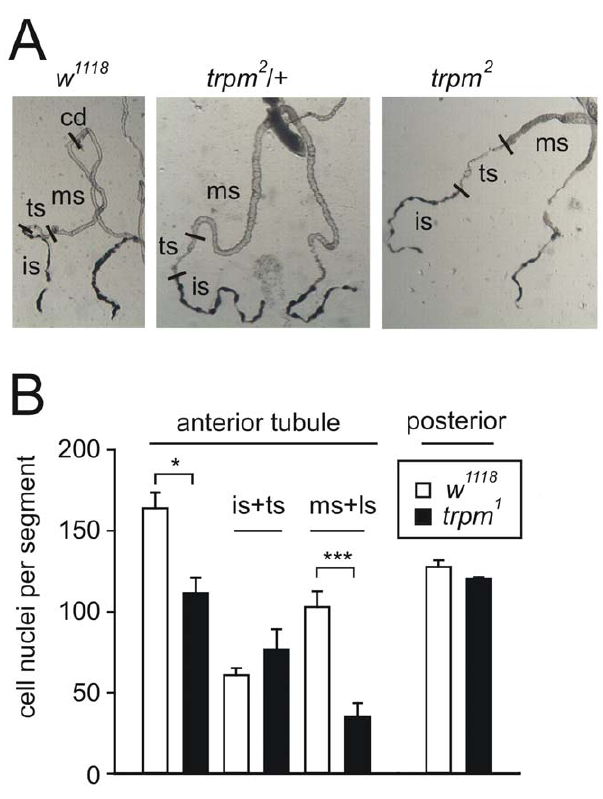
Figure 4. Altered Malpighian tubule morphology in the trpm mutant. (A) Representative images of anterior tubule pairs microdis- sected from 3 rd instar larvae. The approximate location of the different segment borders are indicated: cd = collecting duct, ms = main segment, ts = transitional segment, is = initial segment). (B) Cell numbers in the w 1118 and trpm tubules. The tubules were fixed and stained with DAPI and the numbers of nuclei in each tubule/segment were tabulated. Error bars represent SEMs.